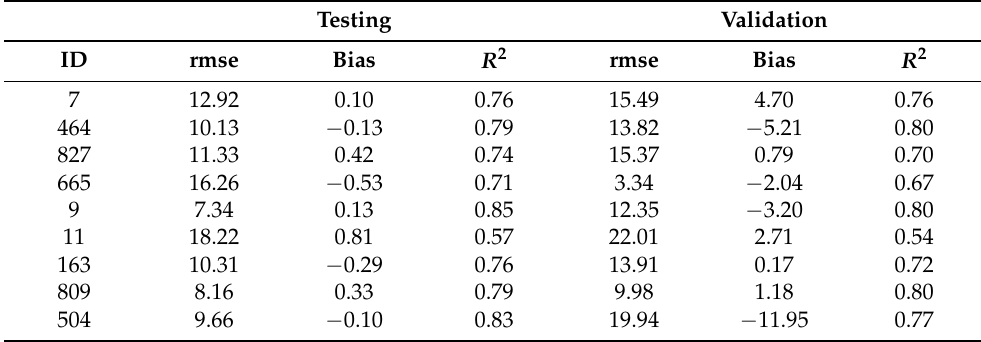
Table 6. Metrics of the prediction of the nine monitoring stations measuring NO 2 for the testing phase and the validation